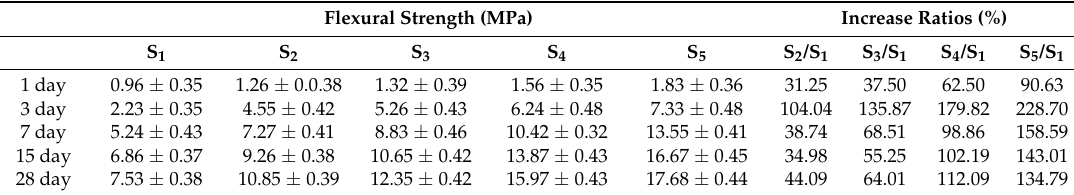
Table 4. Flexural strength of cement composites.